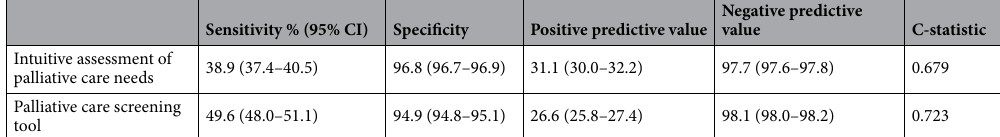
Table 4. Accuracy of intuitive assessment of palliative care needs and PCST in predicting patients’ 6-month mortality. CI, confident